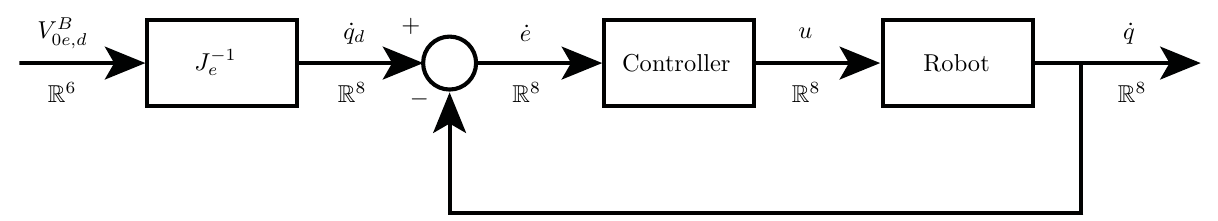
Figure 3: Stiff control by the use of the RCM Jacobian matrix